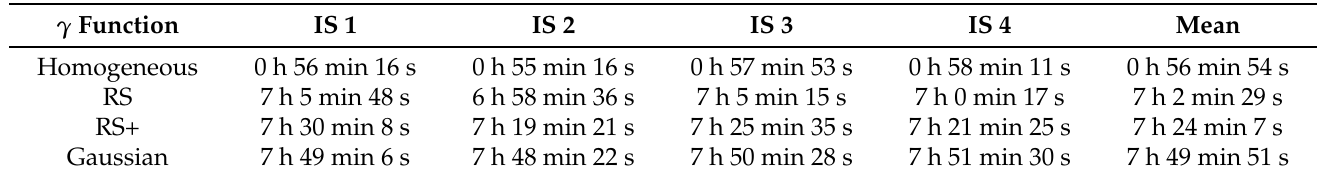
Table 1. CPU-time of all simulations. Mean values are averaged over the four simulations of each γ function, each simulation uses a different initial state